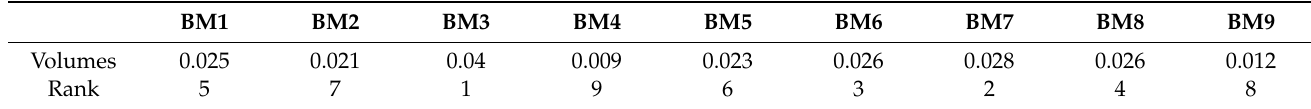
Table 7. Volumes of the complex polyhedra and ranking of the alternatives.